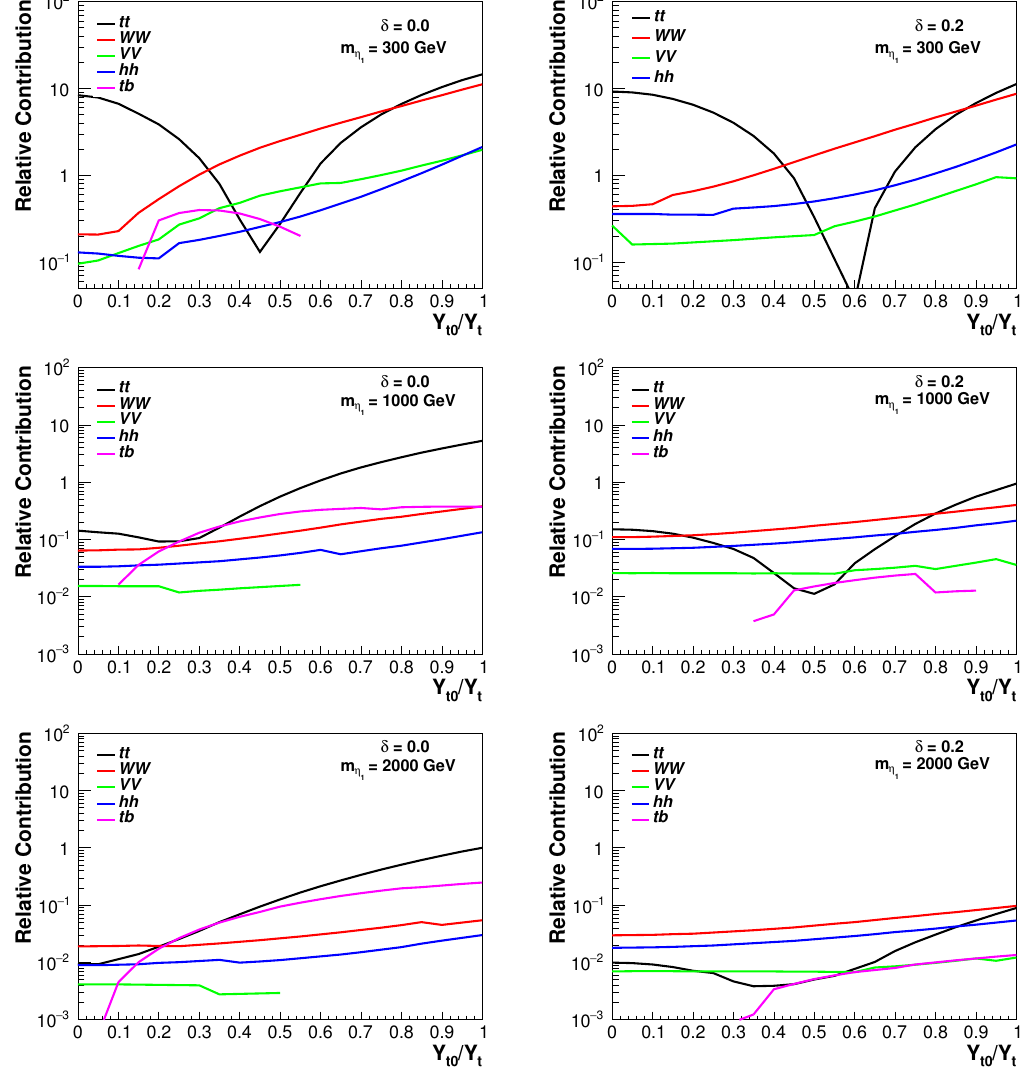
Figure 6 . Contribution of the main (co-)annihilation channels to the inverse relic abundance 1 = (cid:10) (cid:17) which is roughly proportional to the average cross section, as a function of Y t 0 =Y t for di(cid:11)erent choice of the mass. The numerical values are normalised to the observed value. All possible channels are categorised according to their (cid:12)nal states ( V V collects all the di-vector channels except for WW ).